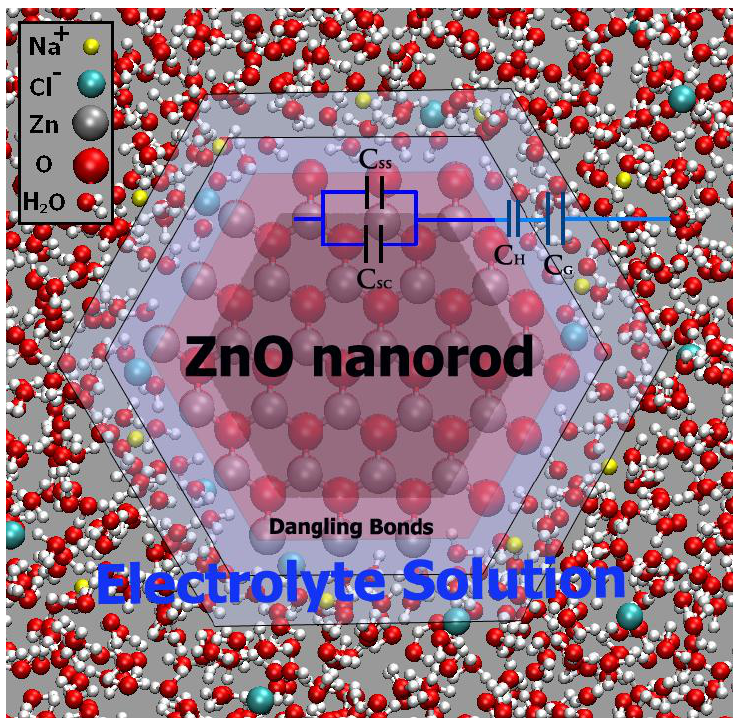
is the surface states capacitance, C SS is Helmholtz layer capacitance, and C H